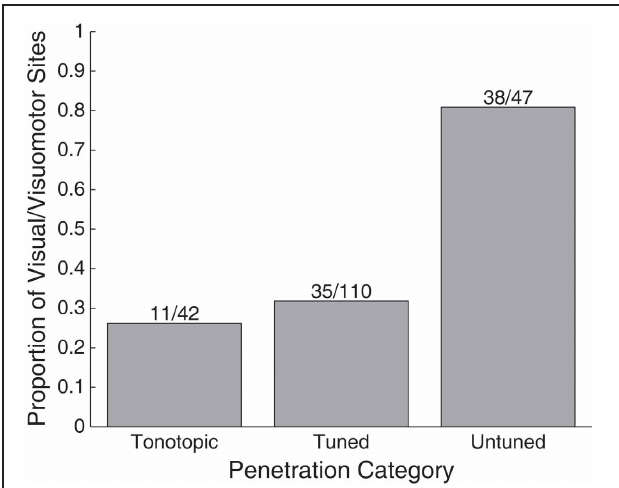
FIGURE 5 | Proportion of visually responsive recordings across recording depth. Data were aligned on the entry into the IC (as measured by the first auditory response in a penetration, i.e., the top of the colored lines in Figure 3 ). Points indicate the proportion of visually sensitive sites at each relative depth, and are marked with the number of responsive and tested sites. Recordings were less common at deeper locations, in part because of the somewhat spherical shape of the IC, and in part because monkeys reached satiety over the course of early